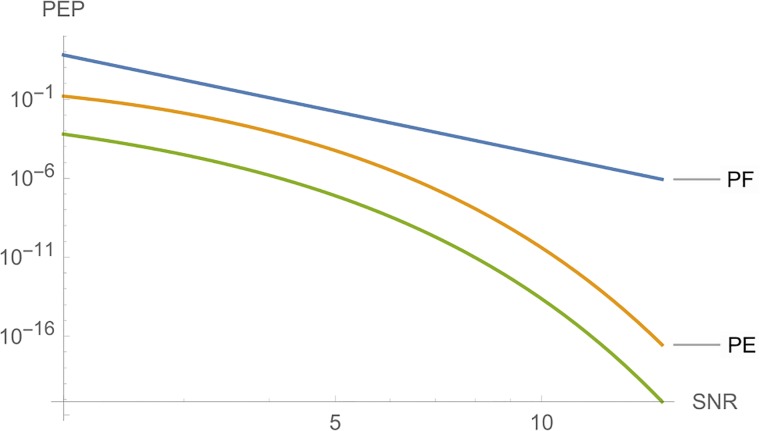
Graphs of PE, PF and PT for Example 5, where nT = nR = l = 3, and SNR is a function of Es.